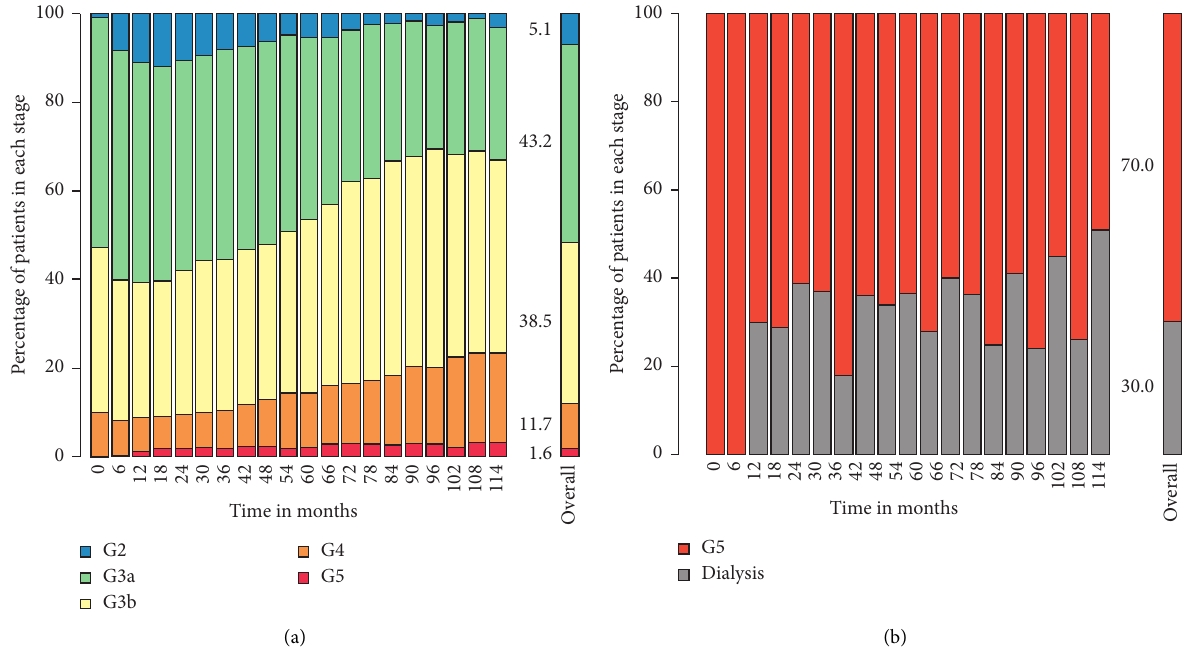
Figure 2: Permanence counts by CKD stages. Each bar’s height represents the proportion of patients by CKD stage at the end of each 6- month period. On the right is a subset of patients who achieve CKD stage G5 or dialysis. The overall bar represents the total proportion of all counts during follow-up, expressed as a